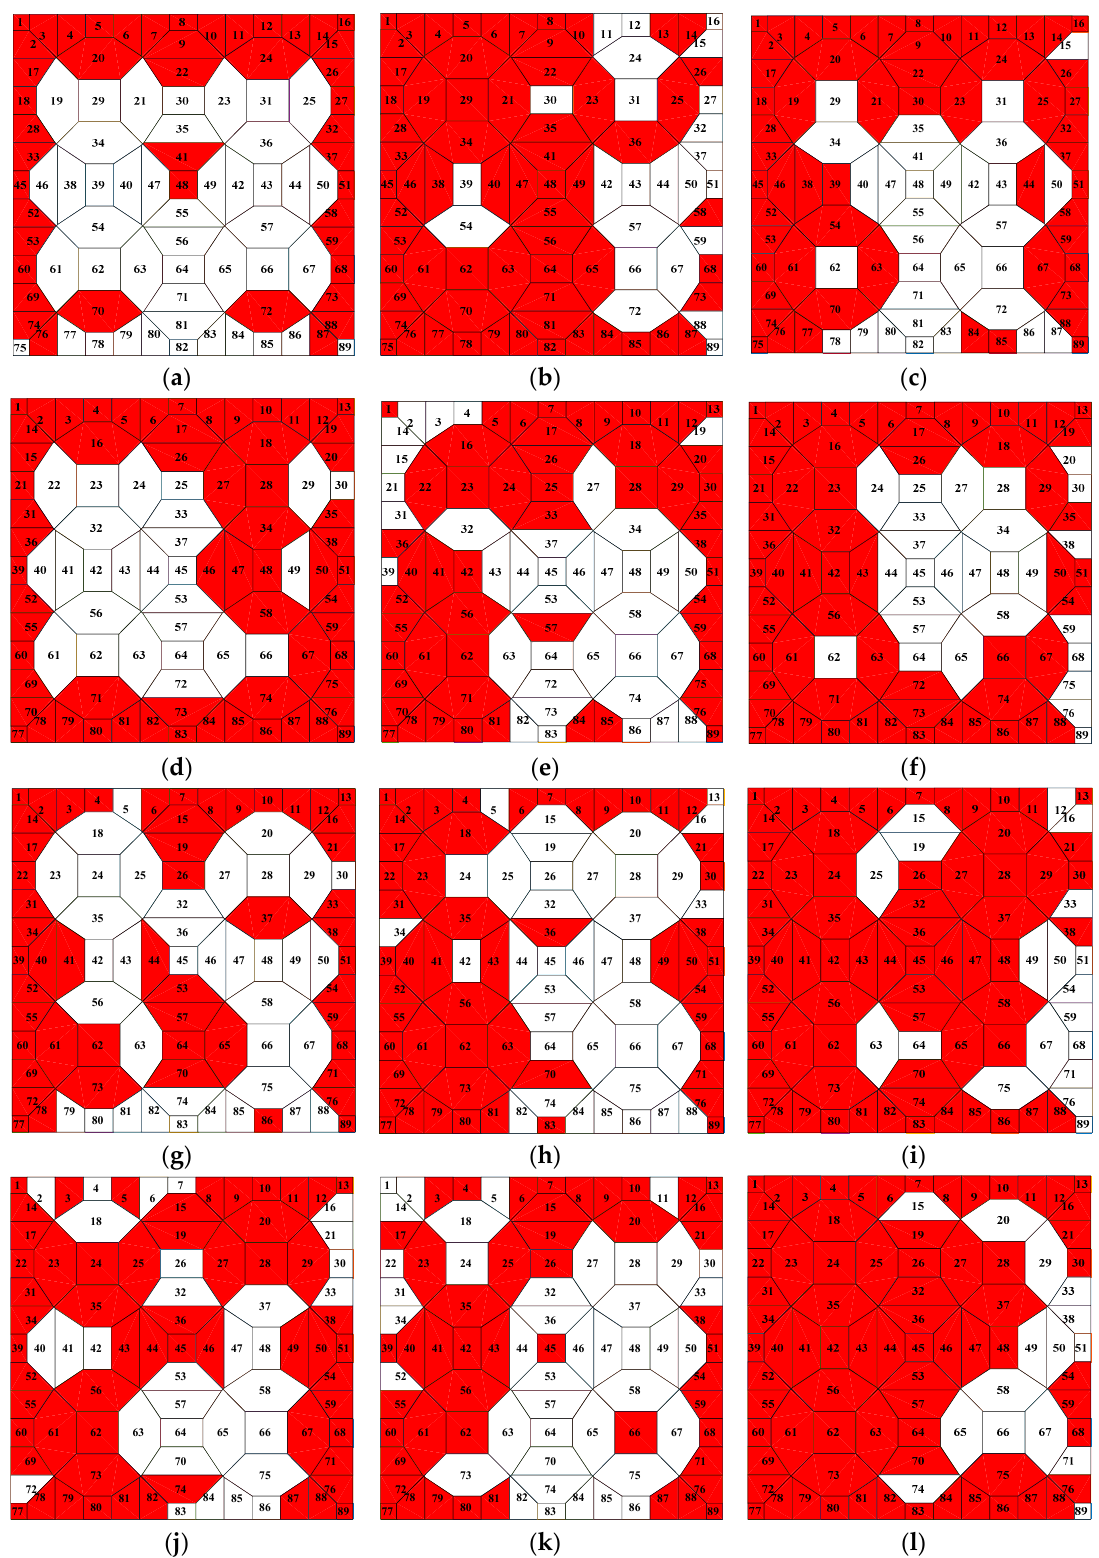
Figure 5. Gaussian process distribution on the roofs, model 1 α = 0° ( a ), α = 45° ( b ), and α = 90° ( c ); model 2 α = 0° ( d ), α = 45° ( e ), and α = 90° ( f ); model 3 α = 0° ( g ), α = 45° ( h ), and α = 90° ( i ); model 4 α = 0° ( j ), α = 45° ( k ), and α = 90° ( l ).